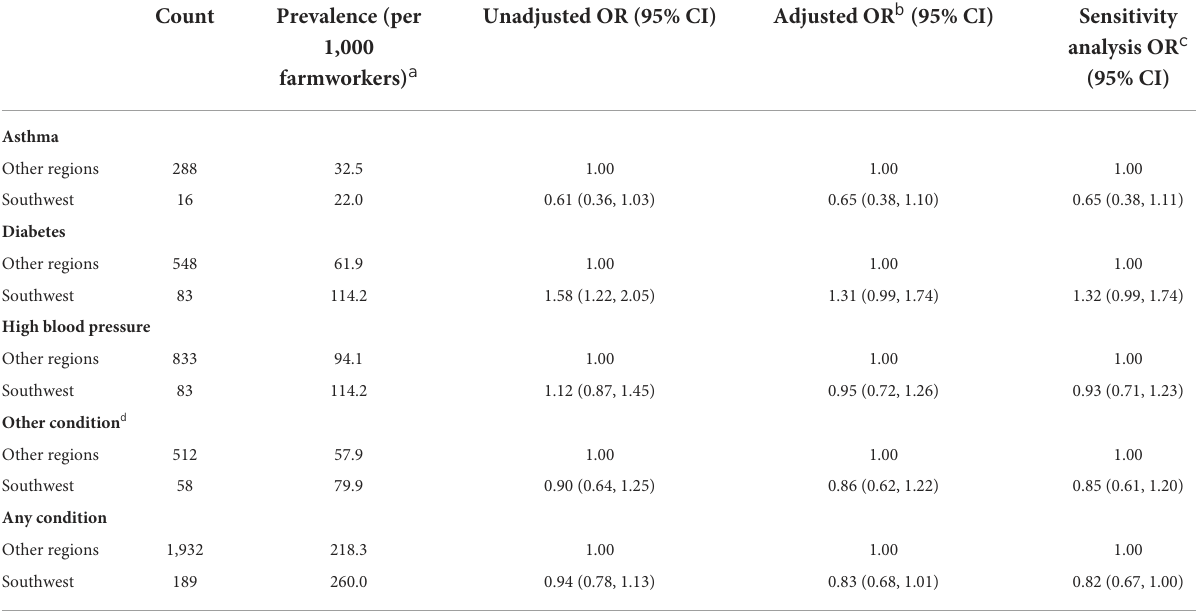
TABLE 3 Health conditions reported by farmworkers interviewed in NAWS, Southwest ( n = 727) compared to other regions ( n = 8,850)